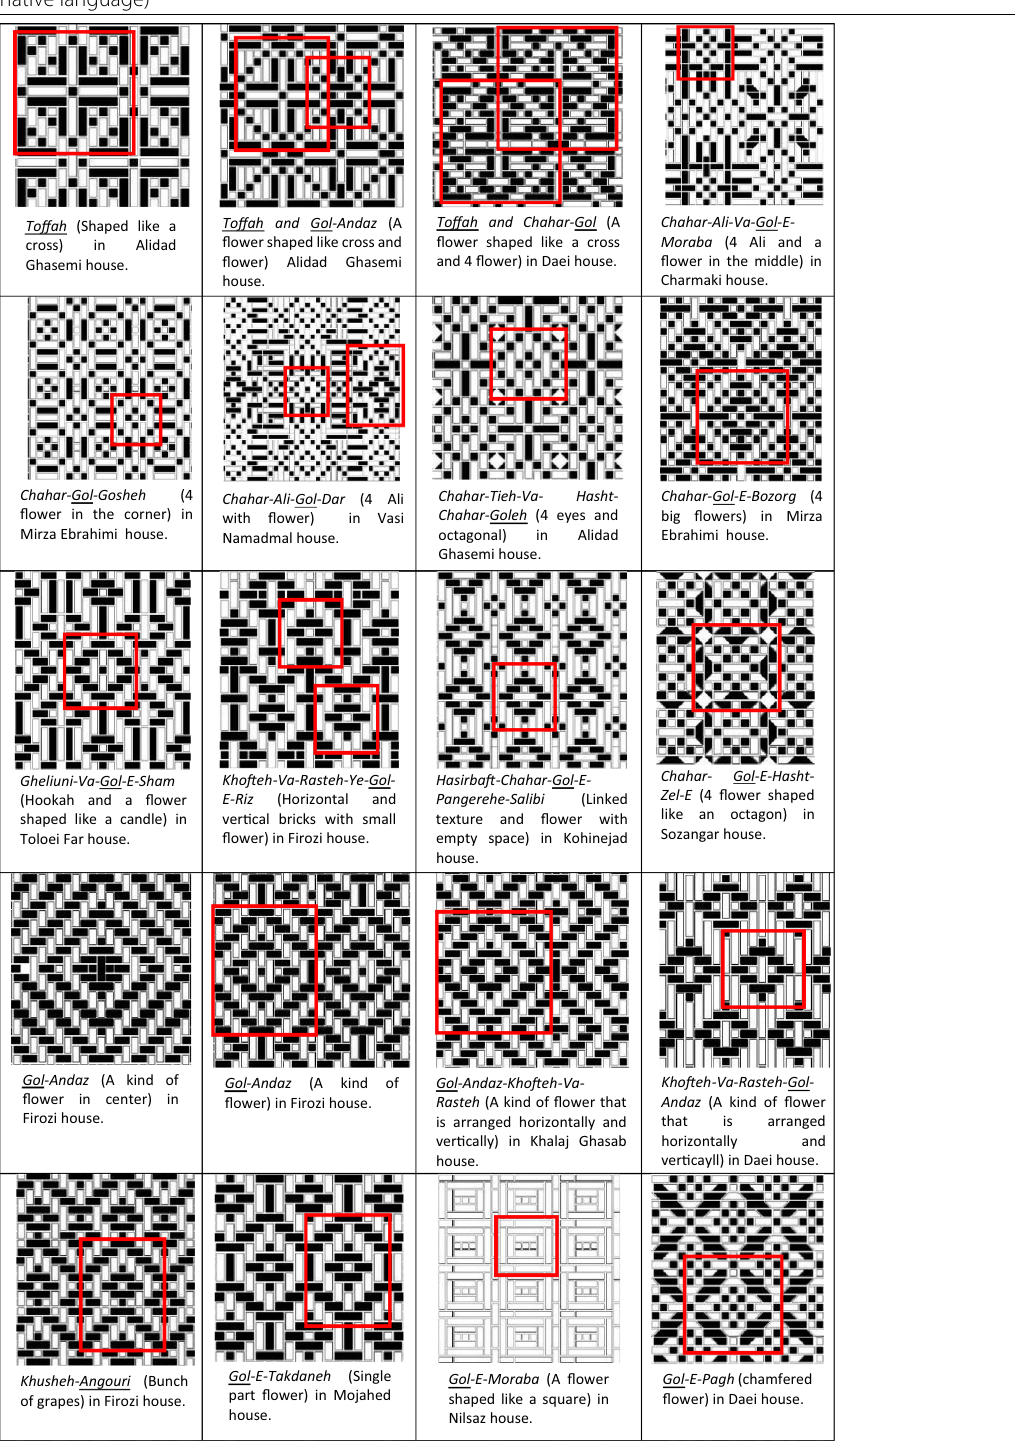
Table 3 The Xowun names in plant and nature motifs (the name of the brick decoration is derived from architectural terms in the native language)